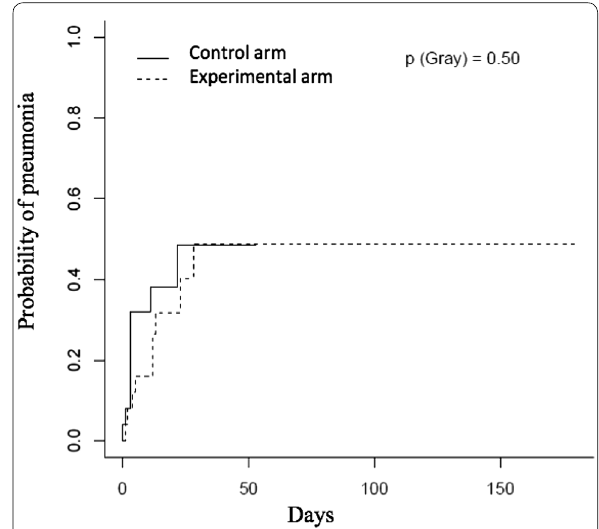
Fig. 2 Time to the first episode of hospital acquired pneumonia